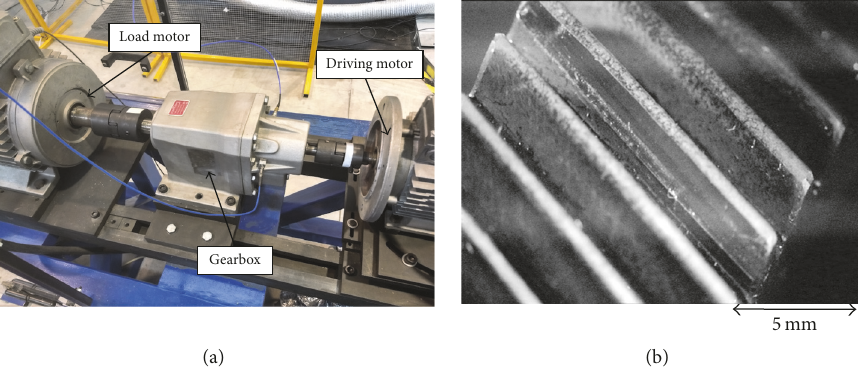
Figure 12: (a) Experimental setup of Case 1 and (b) gear with a spalled tooth.